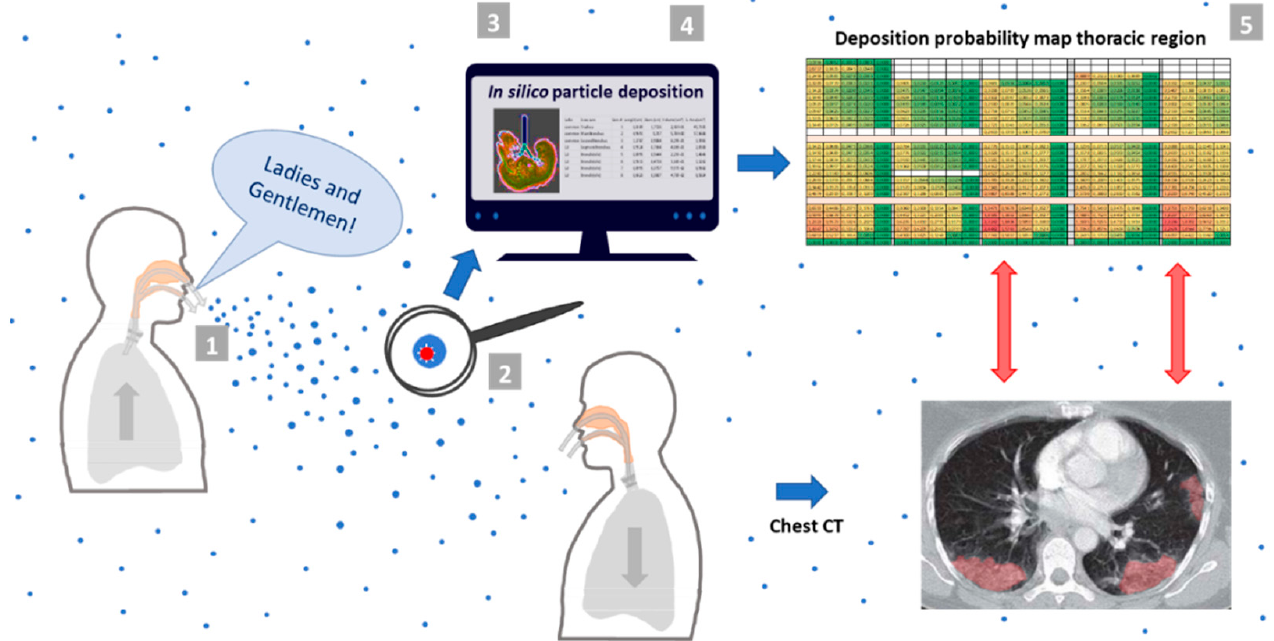
Figure 1. Schematic representation of the study concept and modeling. Virion-laden aerosol particles that are exhaled in the course of vocalization are immediately converted to ambient air respiratory aerosol particles (ARAPs) and remain airborne for hours. In silico modeling was used to determine whether these particles, if inhaled by exposed individuals, advance to the thoracic region and lead to preferred deposition in the distal regions of the lung. The spatial correlation of deposition hot spots with CT anomaly pattern (marked in red) would confirm disease initiation in the peripheral lung by these aerosols. For in silico simulation a five-step modeling and analysis procedure (indicated by grey boxes) was performed: step one—defining the physicochemical properties of exhaled respiratory aerosol particle upon generation; step two—establishing the physicochemical and particokinetic properties of these particles after conversion to ARAPs by evaporation to equilibrium with ambient air conditions; step three—establishing a detailed lung data model for ARAP deposition based on the Yeh/Schum 5-Lobe model [33]; step four—in silico simulation of ARAP deposition via Multiple Path Particle Dosimetry model [34,35] and International Commission on Radiological Protection model [36]; step five—refining resulting raw data by a top-down approach to provide detailed, spatially-resolved information on particle deposition in the thoracic region of the